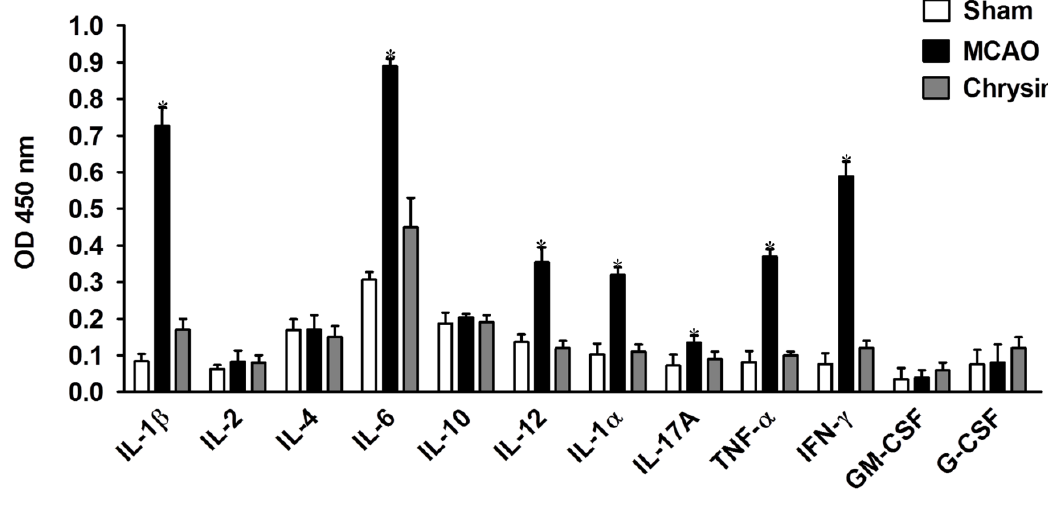
Figure 6. Chrysin reduced the secretion of proinflammatory cytokines. The brain tissue supernatants in mice that underwent 1 h of ischemia followed by 24 h of reperfusion were measured by ELISA. IL-1β, IL-6, IL-12, IL-1α, IL-17A, IFN-γ and TNF-α were inhibited, however, IL-2, IL-4, IL-10, G-CSF and GM-CSF showed no significant changes. The results are presented as mean OD ± SEM. * p < 0.05, vs. MCAO group, n =